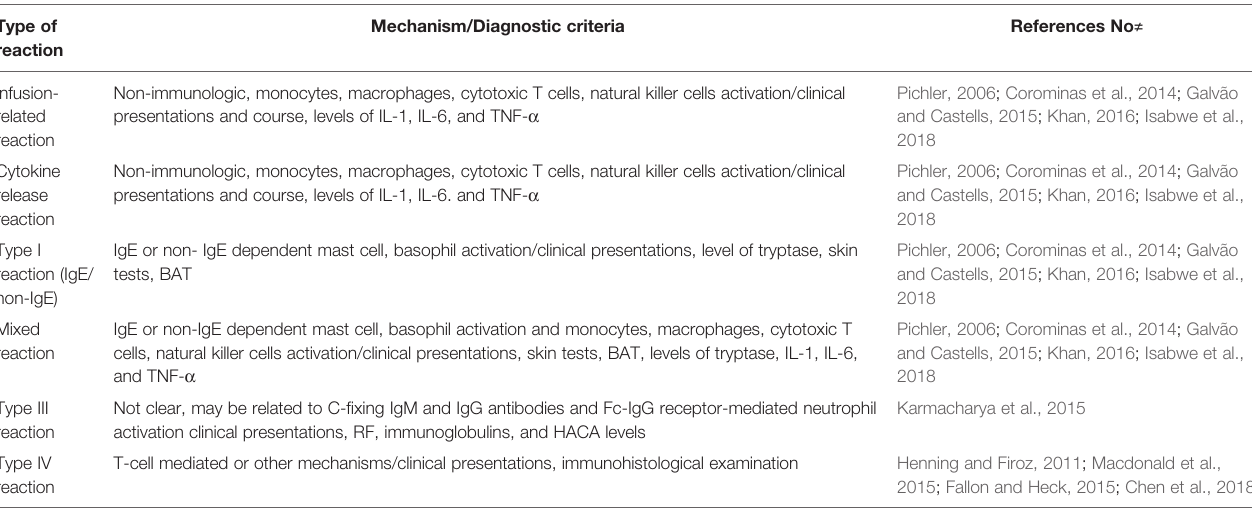
TABLE 1 | Classi fi cations of hypersensitivity reactions to biological agents including